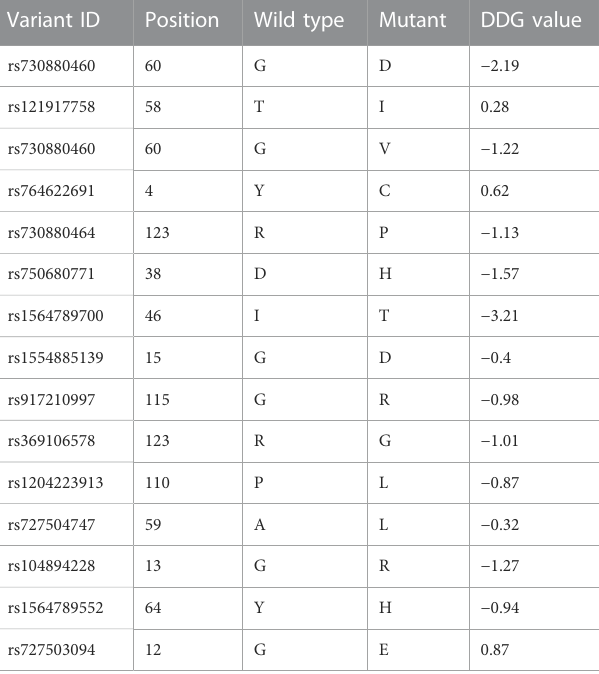
TABLE 2 Non-synonymous single nucleotide polymorphisms (nsSNPs) and their predicted effects on protein function. Variant